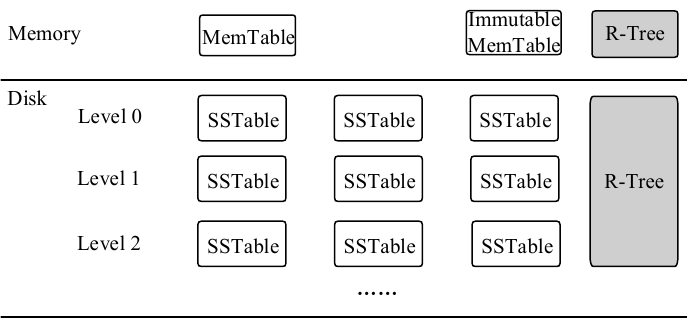
Figure 2. Stand-alone R-tree indexes on LSM-trees.